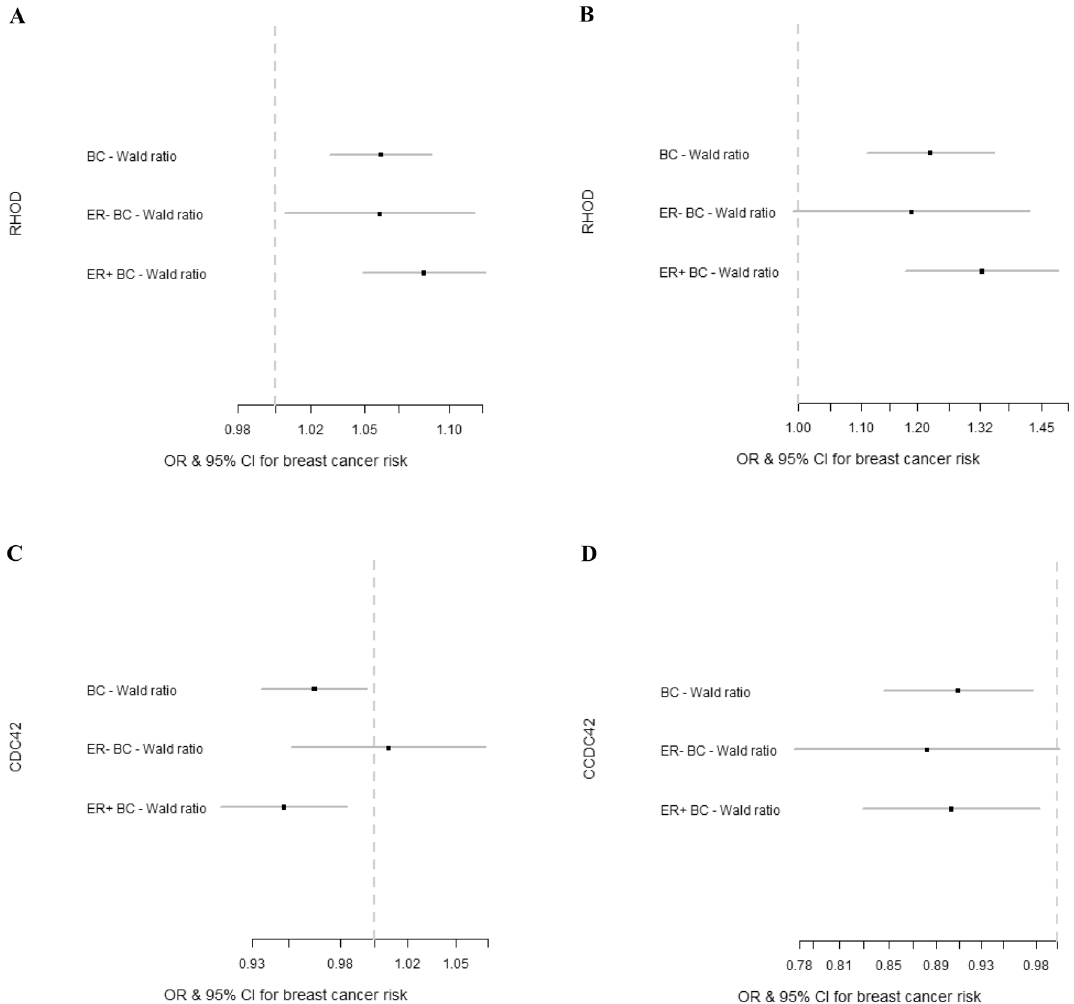
Figure 3. Results of MR analyses performed for overall, ER+ and ER− breast cancer risk for RHOD and CDC42 . The genetic instruments for RHOD were obtained from breast mammary tissue (GTEx) ( A ) and from blood (eQTLGen) ( B ) and for CDC42 were obtained from blood (eQTLGen) ( C ) and from breast cancer tissue (TCGA) ( D ). BC breast cancer, OR odds ratio, CI confidence